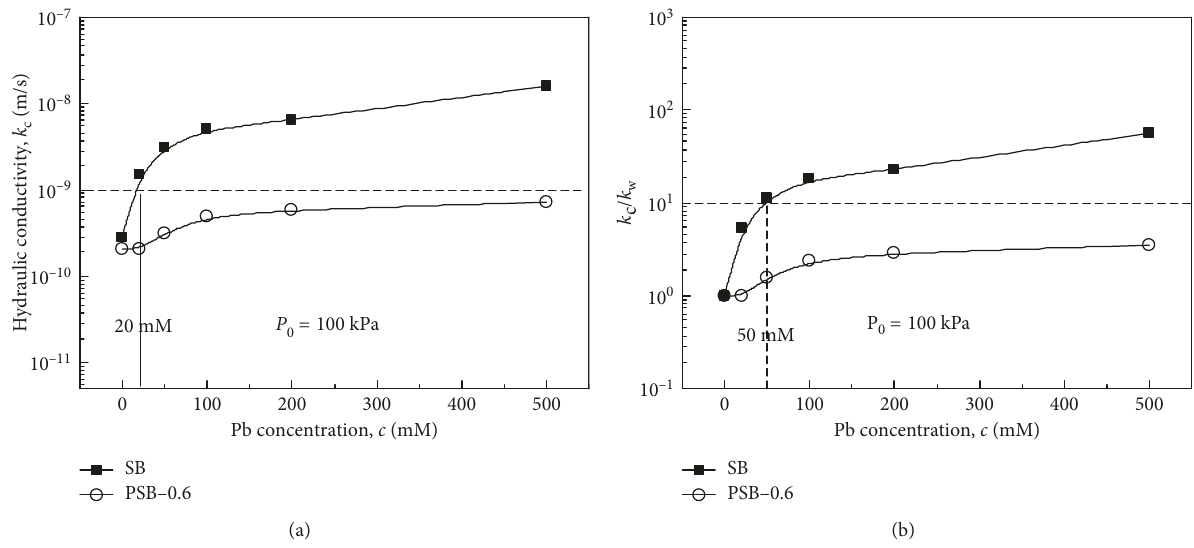
Figure 9: The relationship between (a) hydraulic conductivity of ( k ratio ( k c / k w ) of backfills and c